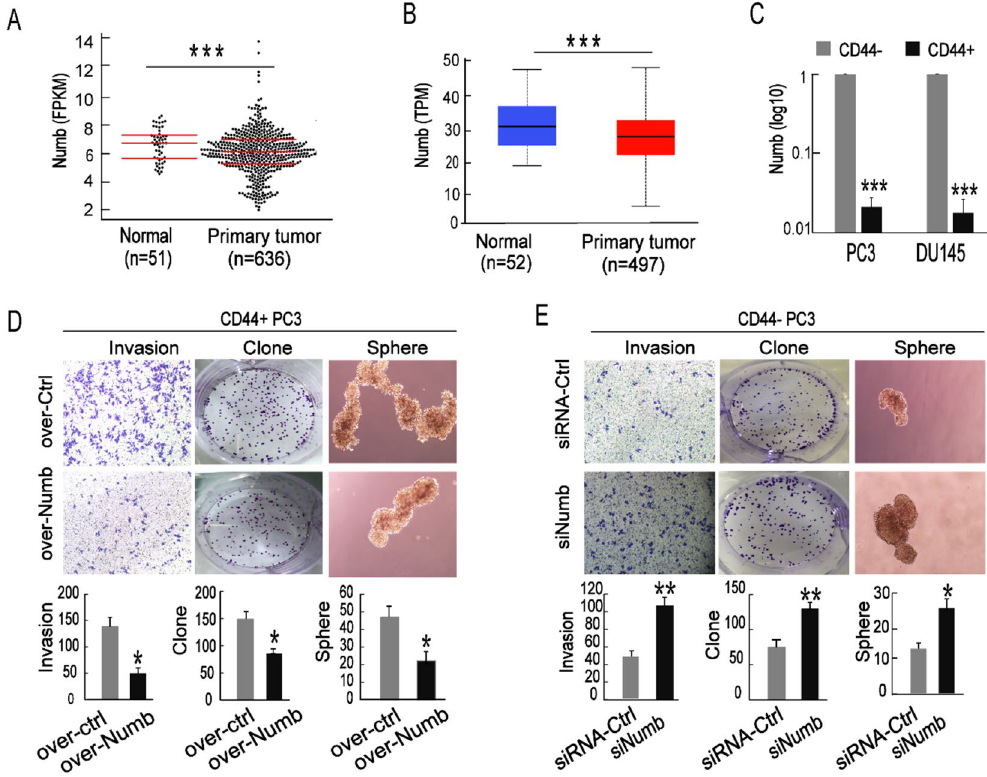
Figure 1. NUMB has an inhibitory role in PCa and PCSCs. ( A , B ) The TCGA database and StarBase v3.0 (http:// starb ase. sysu. edu. cn/) were analyzed to detect expression differences of NUMB genes in normal tissues and primary tumors (FPKM = Fragments Per Kilobase Million, TPM = Transcripts Per Million). ( C ) qRT-PCR was used to detect NUMB expression differences in CD44+ and CD44− PC3 cells. ( D ) Transwell invasion, clone formation and sphere formation assays were performed with CD44+ PC3 cells transfected with pcDNA3.1- Numb (Over-Numb) or pcDNA3.1-Ctrl (Ctrl-Numb). ( E ) Transwell invasion, colony formation and